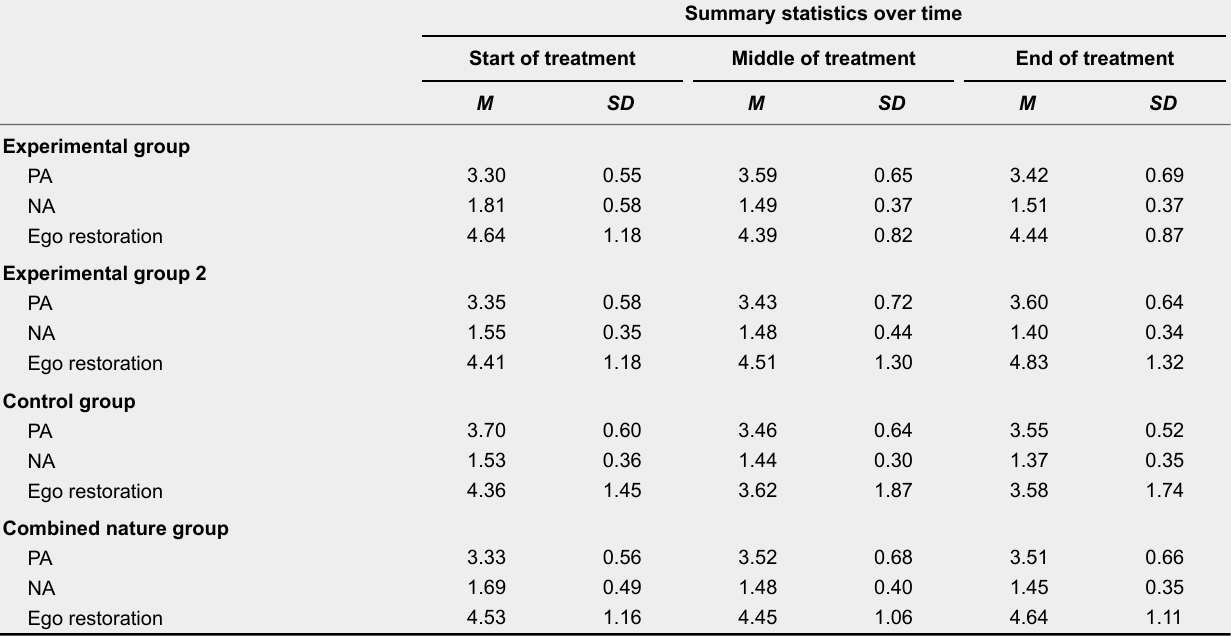
Summary Statistics Over Time for Experimental